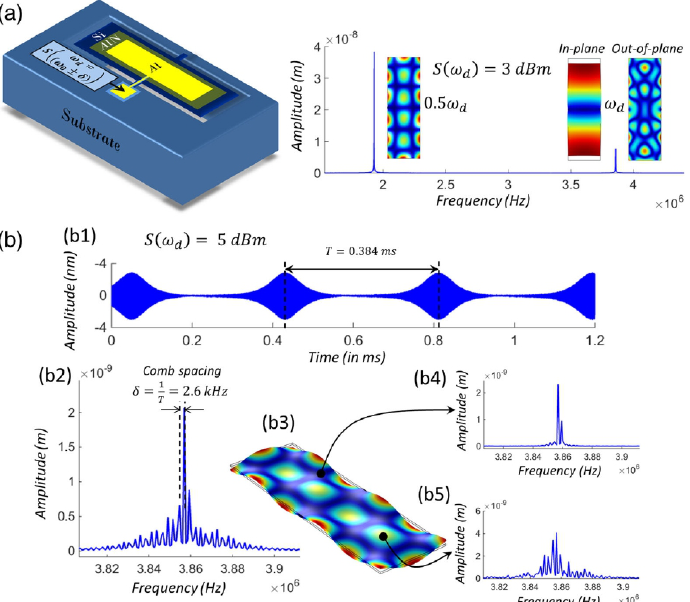
Figure 4. Generation of a phononic FC using nonlinear acoustic resonances in a piezo-electrically driven micromechanical resonator. ( a ) Left: Sketch of the micromechanical resonator. Right: Spectrum amplitude plot showing a parametric excitation of an out-of-plane subharmonic mode of the resonator that is tuned on its in-plane extensional mode using a driving signal S ( ω d ) = 3dBm. Panels ( b1 , b2 ) show a pulse train corresponding to the FCs generated at S ( ω d ) = 5dBm and its spectrum, respectively. One can see the peaks with an interpeak spacing of 2.6kHz. Panel ( b3 ) shows the displacement profile of the subharmonic mode. Panels ( b4 , b5 ) demonstrate that the FC generation is possible only using the displacement at an antinode of the subharmonic mode of the resonator. Reproduced with permission from [9]. Copyright 2017 by the American Physical